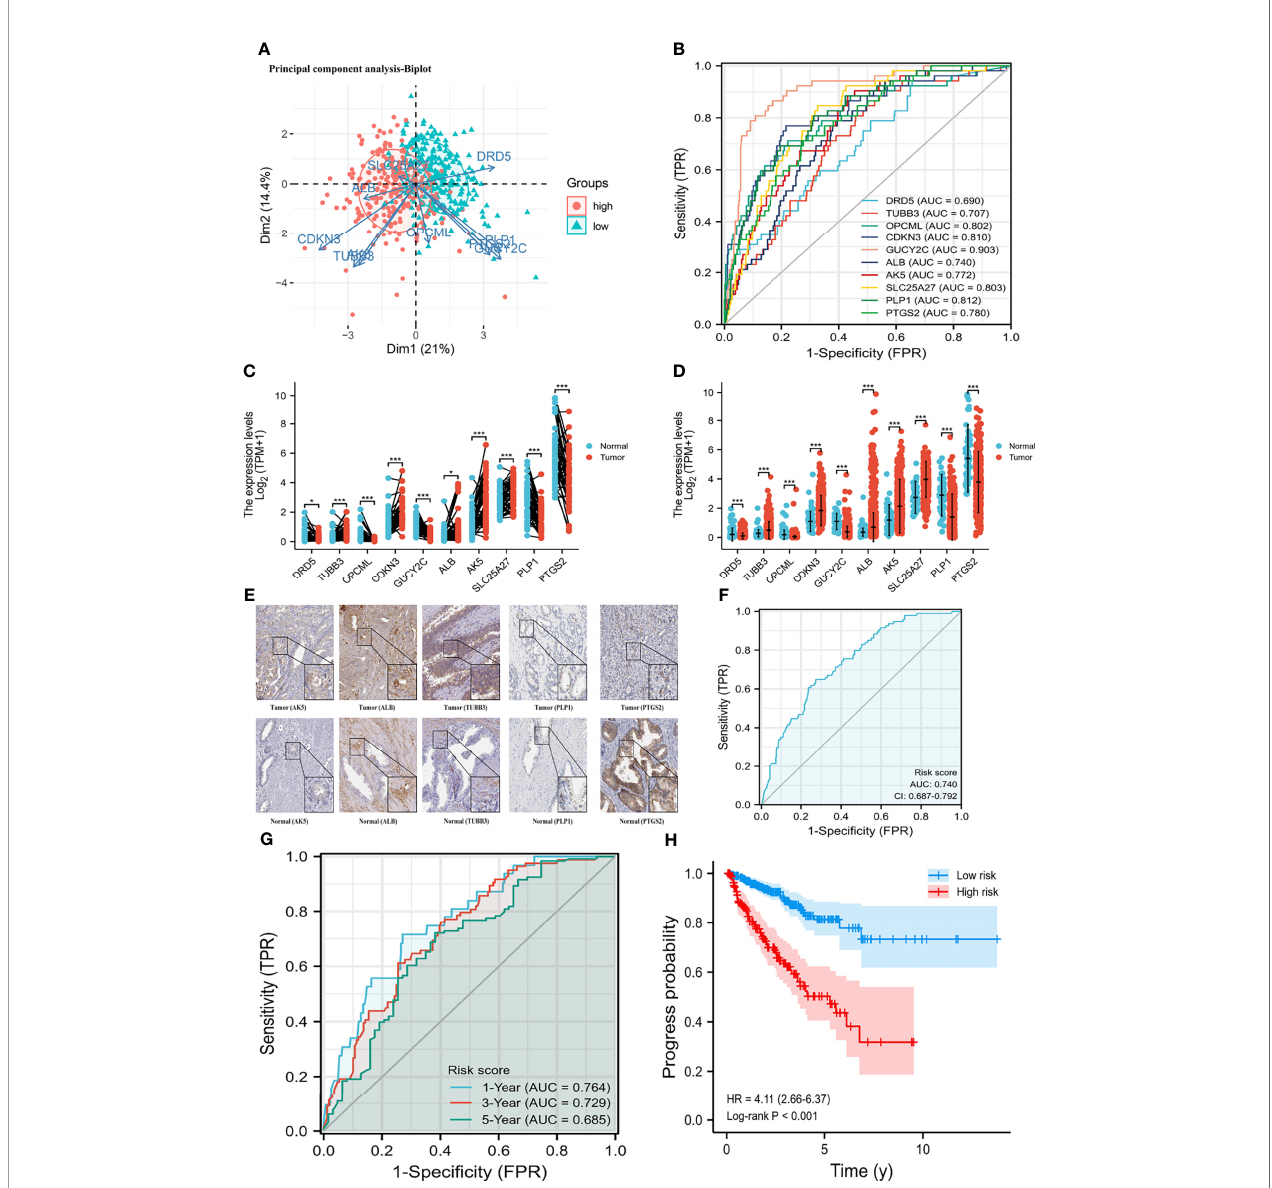
FIGURE 2 | Differential mRNA expression and clinical values of enrolled genes. (A) principal component analysis-Biplot; (B) the receiver operating characteristic curves of genes; (C) gene differential expression in paired samples; (D) gene differential expression in non-paired samples; (E) gene differential expression at protein level; (G) time- dependent receiver operating characteristic curve of risk score; (H) Kaplan-Meier curve of two risk groups. HR, hazard ratio; AUC, area under curve; CI, con fi dence interval. (F) the receiver operating characteristic curve of risk score for prostate cancer progression. *means smaller than 0.01; **means smaller than 0.01; ***means smaller than